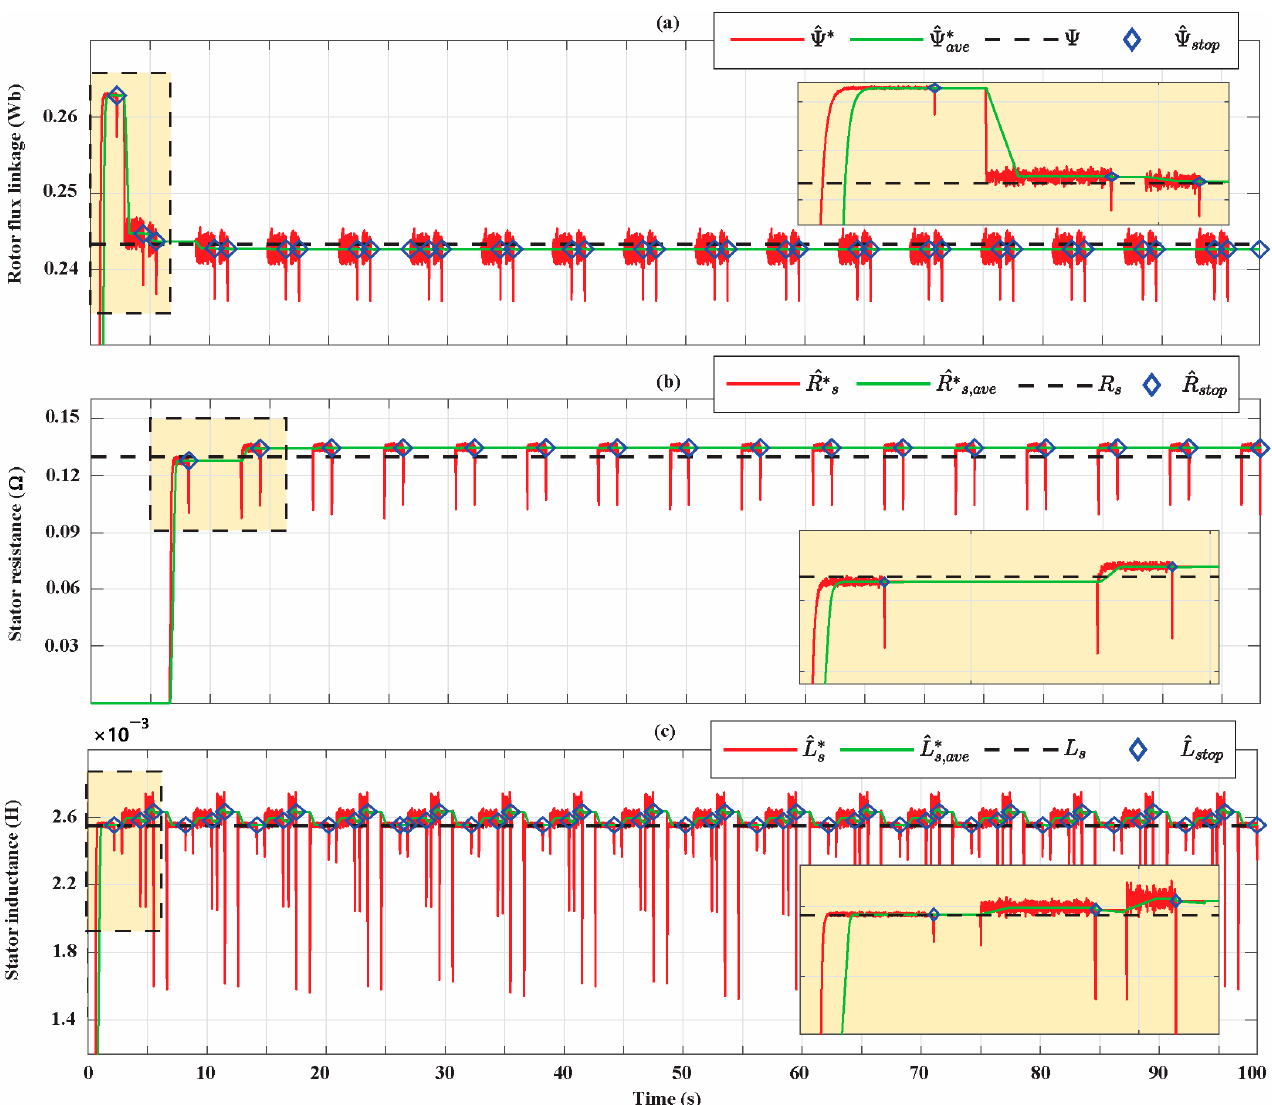
Figure 14. ( a ) Rotor flux linkage estimation for the Bonfiglioli 170; ( b ) stator resistance estimation for the Bonfiglioli 170; ( c ) stator inductance estimation for the Bonfiglioli 170.